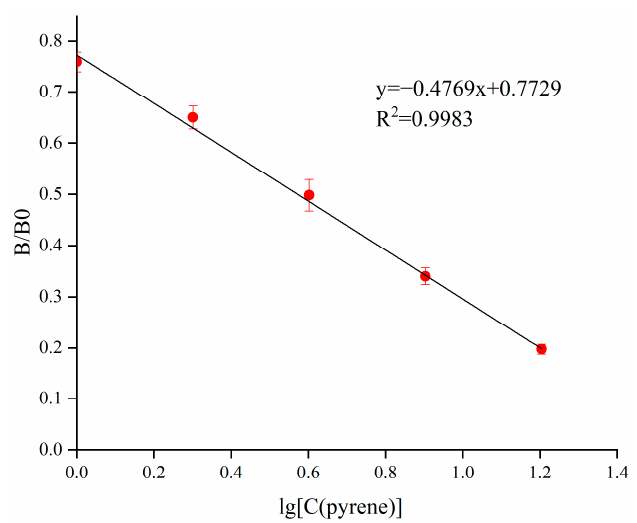
Figure 4. Standard curve for PYR in the ic-ELISA.